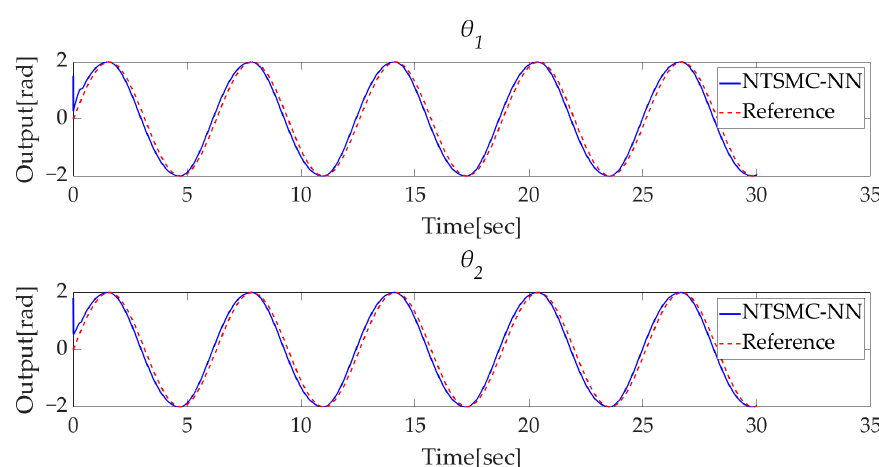
Figure 9. NTMSC-NN control performance for continuous input.